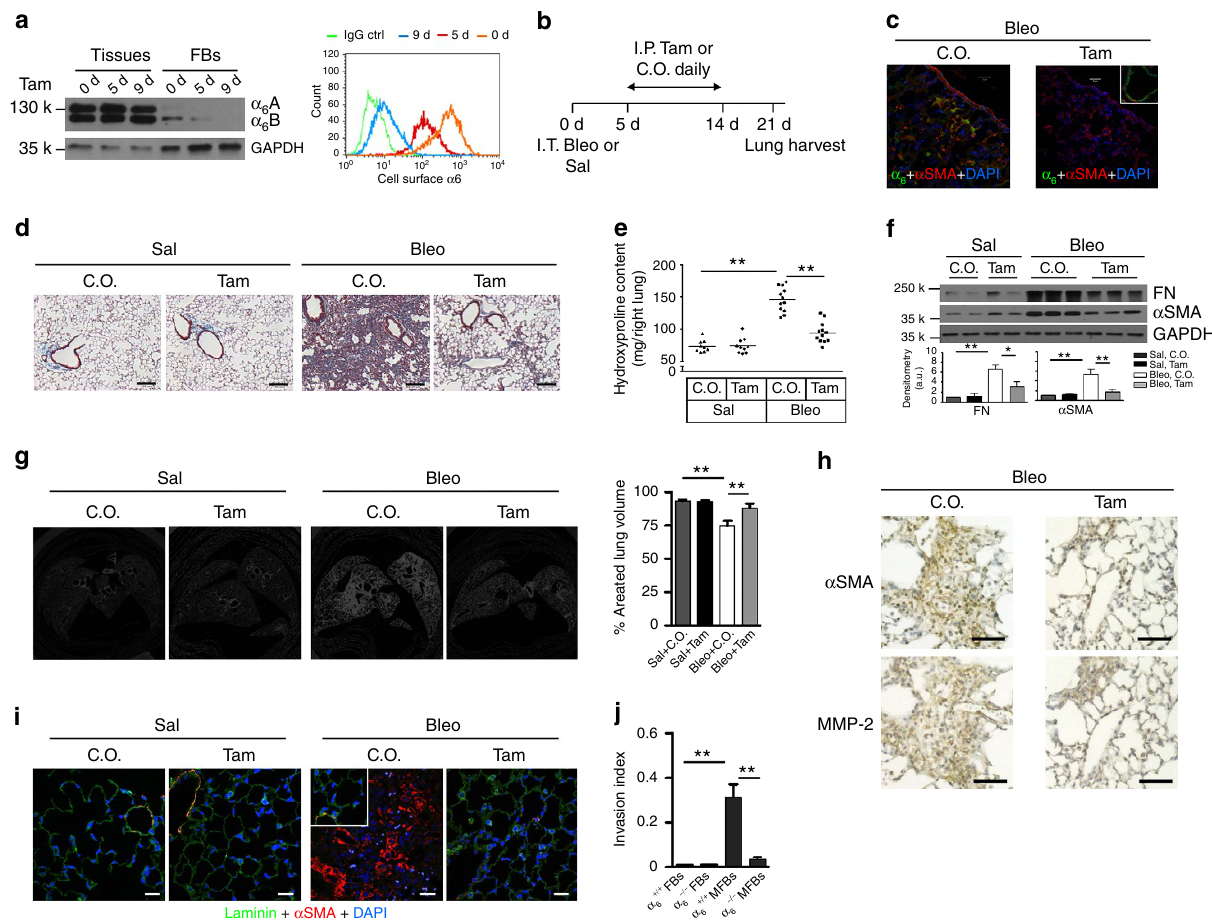
Figure 4 | Fibroblast-specific deletion of a 6 protects mice against bleomycin injury-induced experimental lung fibrosis. ( a ) Time-dependent deletion of a 6 -expression in lung fibroblasts in conditional a 6 (cid:2) / (cid:2) mice following tamoxifen (Tam) administration. Levels of a 6 -protein in cell lysates and on the cell surface were determined by immunoblot and flow cytometry. ( b ) Schematic shows the design of animal experiments. ( c ) Frozen lung tissue sections from bleomycin-treated mice were double-stained for a 6 (green) and a SMA (red). Nuclei were stained by DAPI (blue). Confocal immunofluorescent images were overlaid to show a 6 -expression in a SMA-positive lung myofibroblasts. Epithelial a 6 -expression in tam-treated mice was shown in the inset. Scale bar, 20 m m. ( d ) Representative images for trichrome staining of collagens in paraffin-embedded lung tissue sections. Scale bar, 150 m m. ( e ) Quantification of hydroxyproline contents in right lungs of mice from four mouse groups: Sal þ C.O., Sal þ Tam, Bleo þ C.O. and Bleo þ Tam. ( f ) Quantification of fibronectin (FN) and a SMA protein expression in left lungs by immunoblot. Shown are representative blots. ( g ) Shown are representative images for ex vivo mid-lung transaxial m CT scans. The average percentages of aerated lung volumes of mice in four groups ( n ¼ 5 per group) are shown in the bar graph. ( h ) Immunohistochemical staining of two adjacent lung sections shows Mmp-2 expression in the areas of a SMA-expressing lung myofibroblasts. Nuclei were stained by hematoxylin (blue). Scale bar, 100 m m. ( i ) Frozen lung tissue sections were stained for laminin (green) (a component of the BMs) and a SMA (red). Nuclei were stained by DAPI (blue). Inset shows laminin and a SMA staining in the relatively normal area of the same lung section. Scale bar, 20 m m. ( j ) Lung (myo)fibroblasts (FB and MFB) were isolated from mice in four groups. The ability of (M)FBs to invade the BM matrices was determined by invasion assay. Results are the means ± s.d. of three separate experiments, each performed in triplicates; * P o 0.05 and ** P o 0.01; one-way analysis of variance. Bleo, bleomycin; C.O., corn oil; Sal, saline. bleomycin-treated WT mice ( a 6 þ / þ MFBs); primary lung fibroblasts isolated from saline-treated a 6 -CKO mice ( a 6 (cid:2) / (cid:2) FBs) and WT mice ( a 6 þ / þ FBs) showed minimal invasion into the BM (Fig. 4j). c-Fos/c-Jun-dependent mechanotransduction pathway (Fig. 1), pathway protects WT C57BL6 mice against bleomycin injury-induced experimental lung fibrosis. To minimize the injury-induced experimental lung fibrosis in mice (Fig. 5d, hydroxyproline content; Fig. 5e, immunoblot for fibronectin